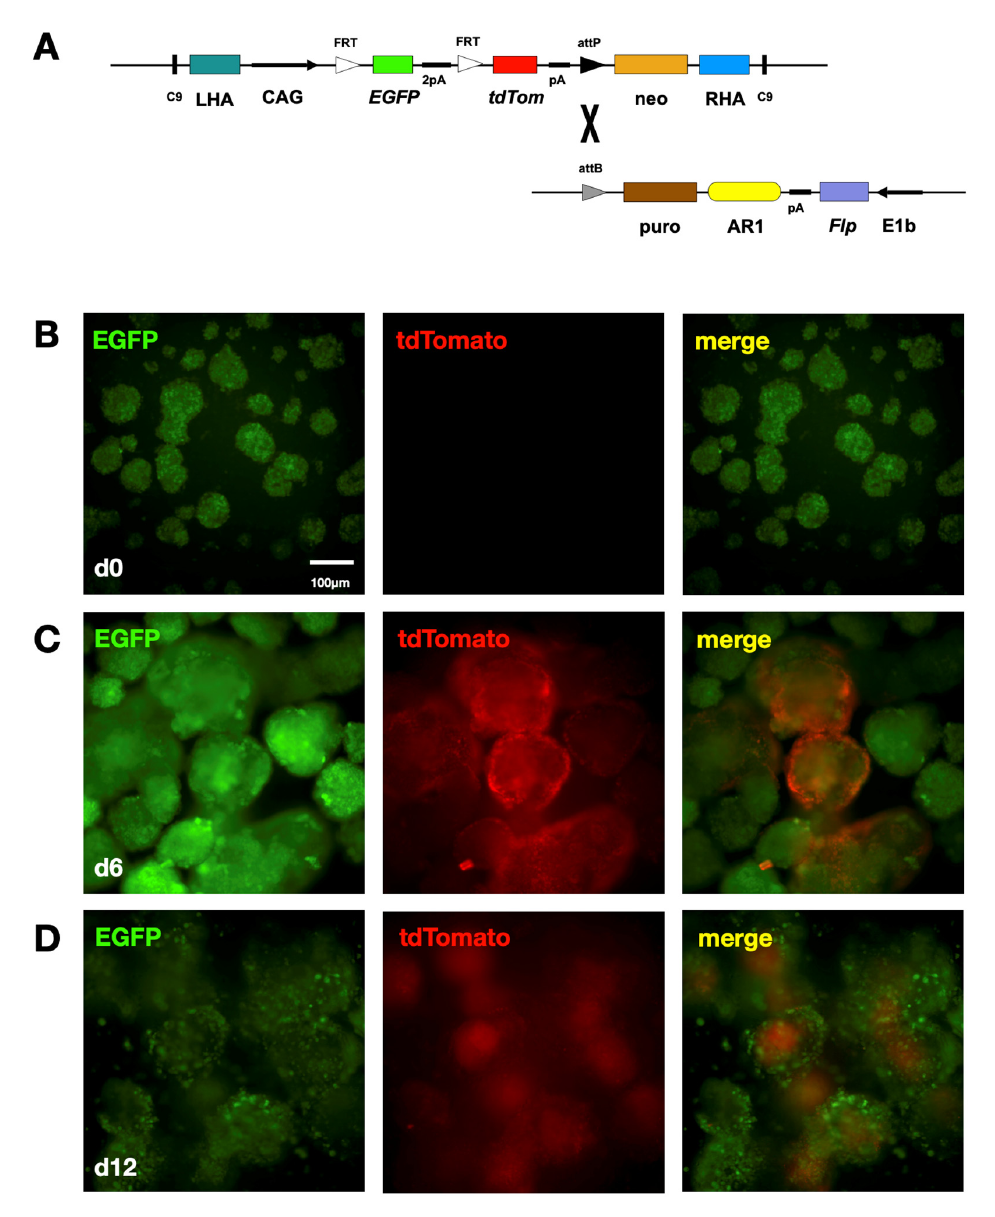
Figure 3. The AR1 cardiac enhancer in Hipp11 activates expression of flippase in differentiating cells. ( A ) Schematic of the EGFP ‐ tdTom and Fpl ‐ AR1 plasmids. The former contains the neomycin resistance cassette (neo) and fluorescent protein ‐ expressing cassette consisting of the EGFP gene and 2 polyadenylation signals (pA) between 2 FRT elements, under the control of the CAG promoter and followed by tdTom. The 2 cassettes, together with an attP element, are flanked by LHA, RHA and two CRISPR/Cas9 target sites (C9). The latter contains an attB element, the puromycin resistance cassette (puro) and flippase (Flp), under the control of the E1b minimal promoter and AR1 enhancer. φ C31 integrase catalyzes the irreversible recombination between attP in Hipp11 and attB in the Fpl ‐ AR1 plasmid, resulting in the insertion of the latter into the former. ( B ) Colonies of undifferentiated EGFP ‐ tdTom/Flp ‐ AR1 mESC showing green fluorescence only. Magnification 10×. ( C , D ) EGFP ‐ tdTom/Flp ‐ AR1 embryoid bodies (EB), on days 6 and 12, showing tdTomato expression. On day 6, red fluorescence is strong and widespread. On day 12, tdTomato ‐ expressing cardiac cells occupy the centre of the EB, while EGFP ‐ expressing non ‐ cardiac cells are seen on the periphery. Magnification 10×.